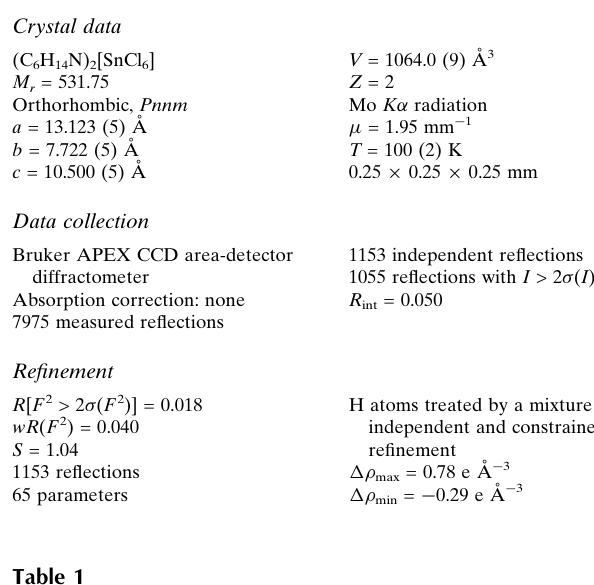
Hydrogen-bond geometry (A˚ , (cid:4)